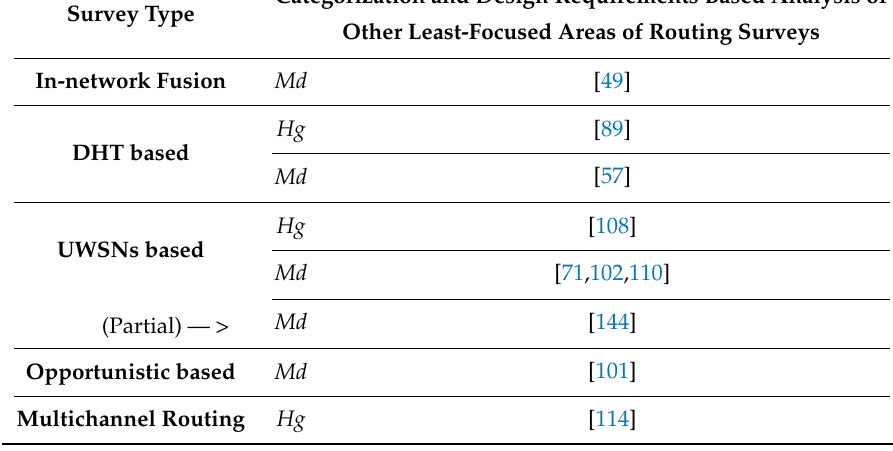
Table 12. Design analysis of other least-focused areas of routing surveys publication in